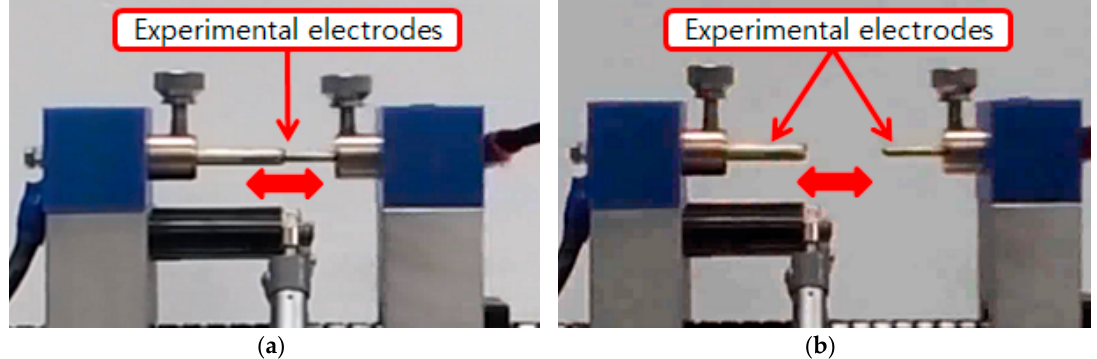
Figure 1. Switching device for experiment; ( a ) ON state, ( b ) OFF state.